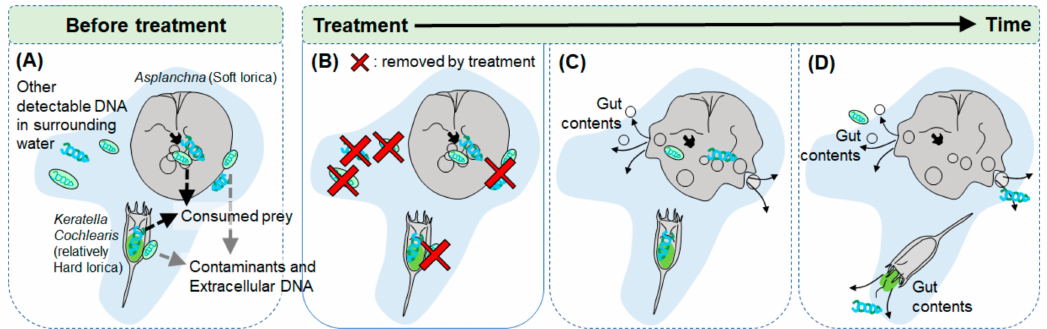
Figure 1. Diagram of necessity of proper pretreatment process in rotifers gut contents analysis; ( A ) Without treatment for removing contaminants and other detectable DNA including extracellular DNA, there is possibility to be confused that detected DNA is from the rotifers gut contents or not, ( B ) Through proper treatment, contaminants and other detectable DNA can be removed without damaging the rotifer individuals, ( C ) and ( D ) Rotifer individuals can be damaged and their gut contents can be overflowed by excessive treatment according to their lorica characteristics.